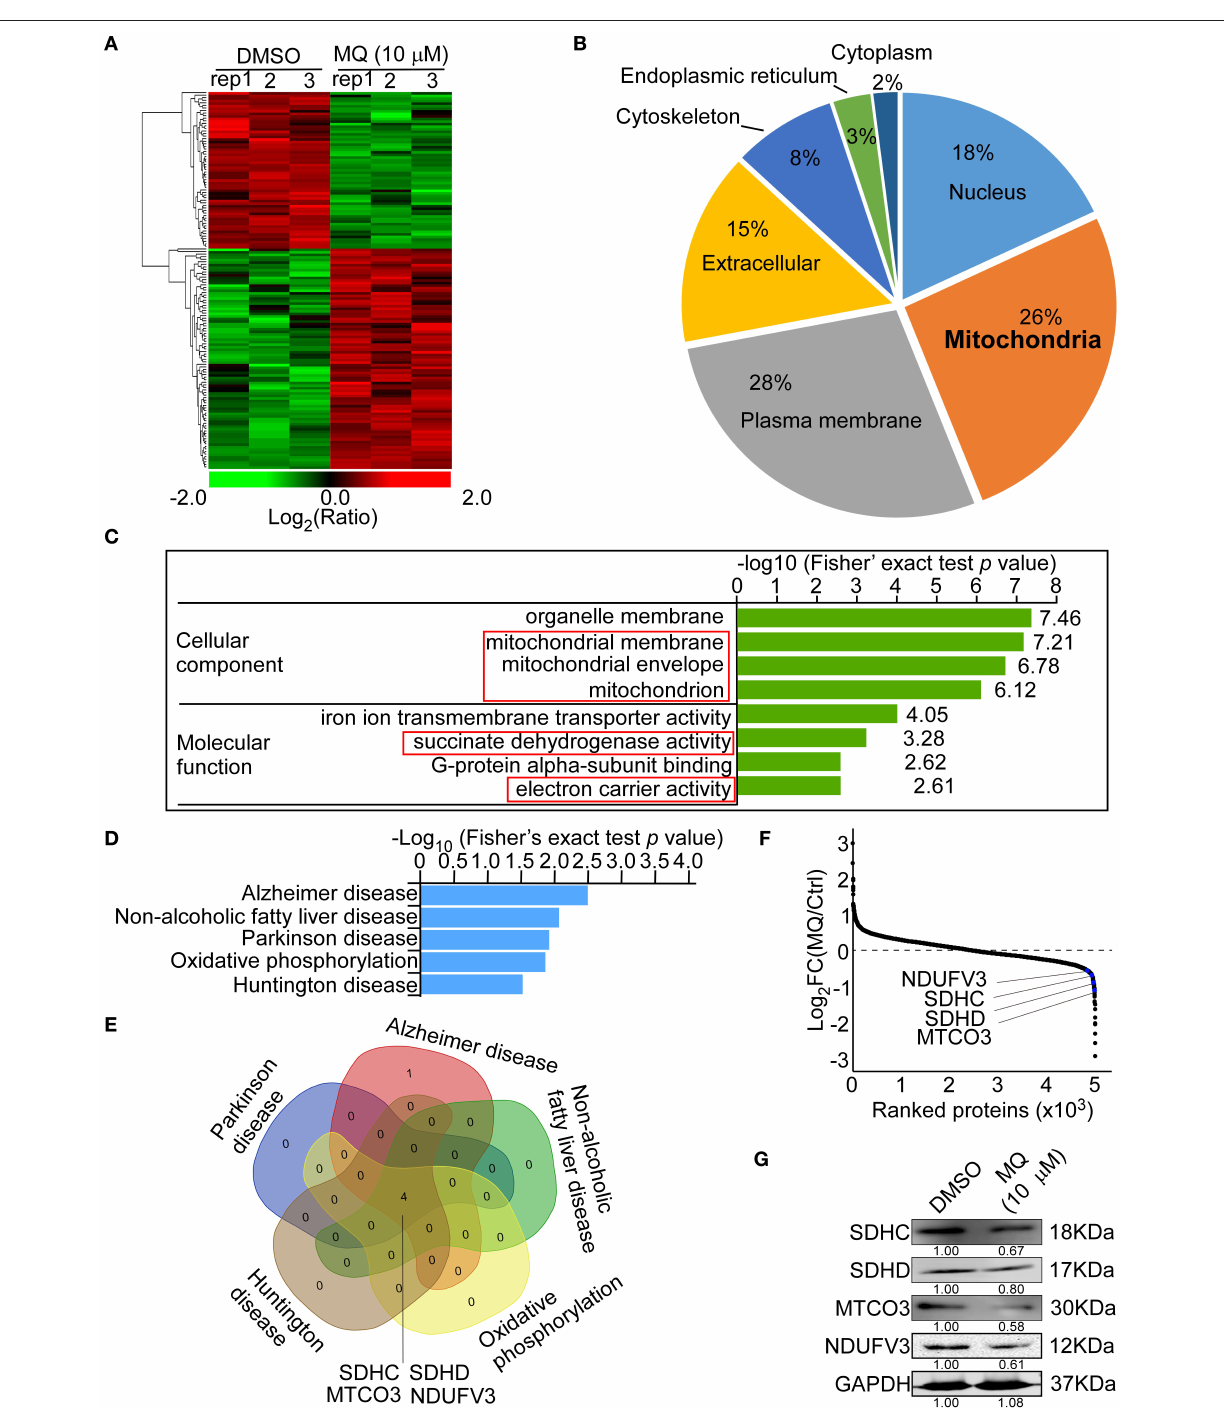
Frontiers in Oncology |